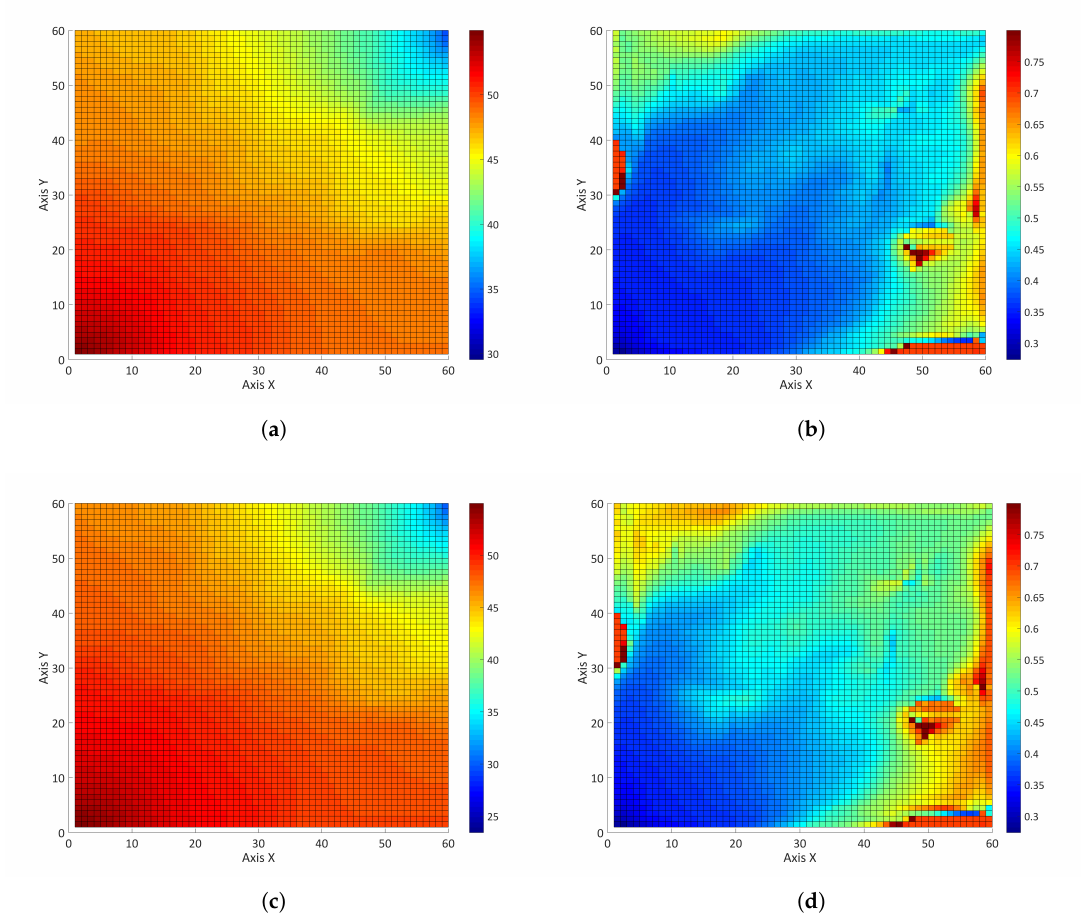
Figure 12. Pressure (in MPa) (left— a and c ) and oil saturation (right— b and d ) during the non-iterative secondary recovery after 9000 days, for the models with petroleum viscosity 50 mPa·s (top— a and b ) and 100 mPa·s (bottom— c and d